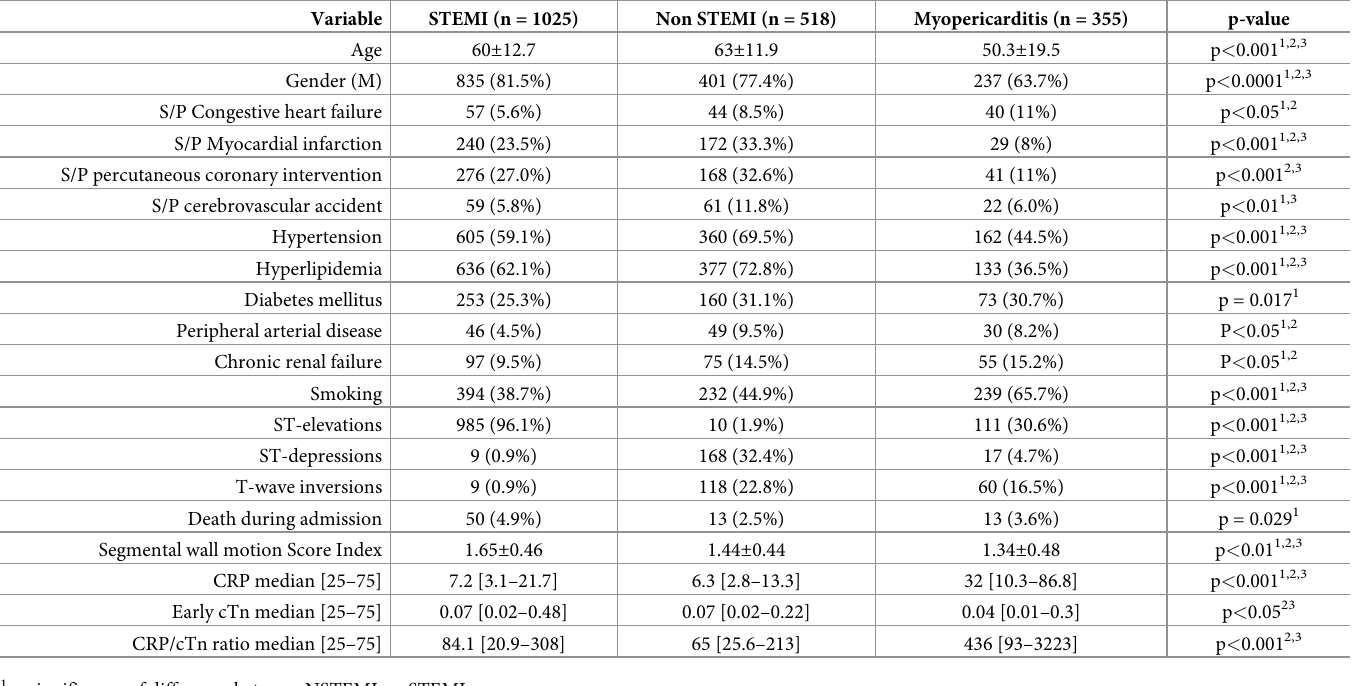
Table 1. The demographic and basic clinical characteristics including CRP and troponin levels and their ratio among study patient groups according to the diagno- sis at